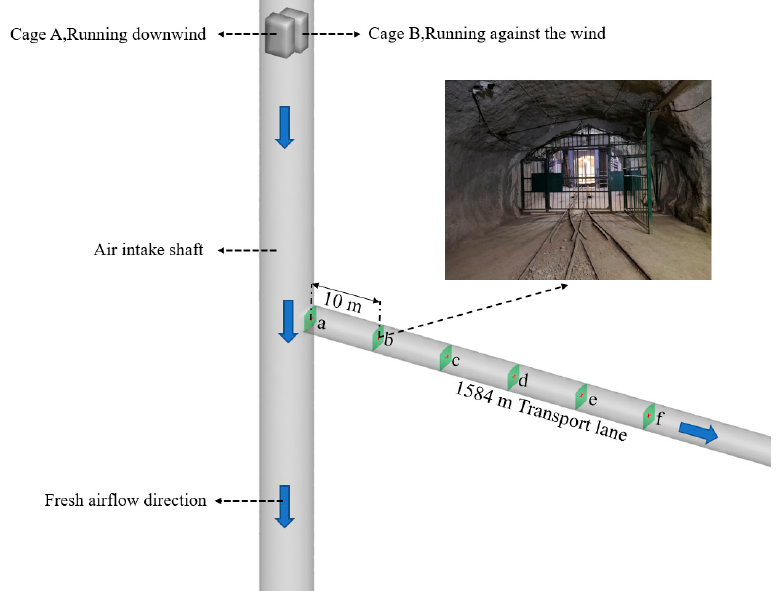
Figure 4. Diagram of measured and simulated wind speed. Only shaft ventilation was measured velocity of 4.4 m/s, cage at a speed of 10 m/s, uniform operation of 48.5 s through the main intake shaft elevation 1374.0~1854.0 m, 1584.0 m transport lane wind speed. The wind speed measurement of each measuring point is carried out simultaneously by the point measurement method. The measur- ing instruments mainly include the ventilation multi-parameter detector (JYF-4), my electronic anemometer (DFA-2), handheld laser range finder (HT-307) and mechanical stopwatch